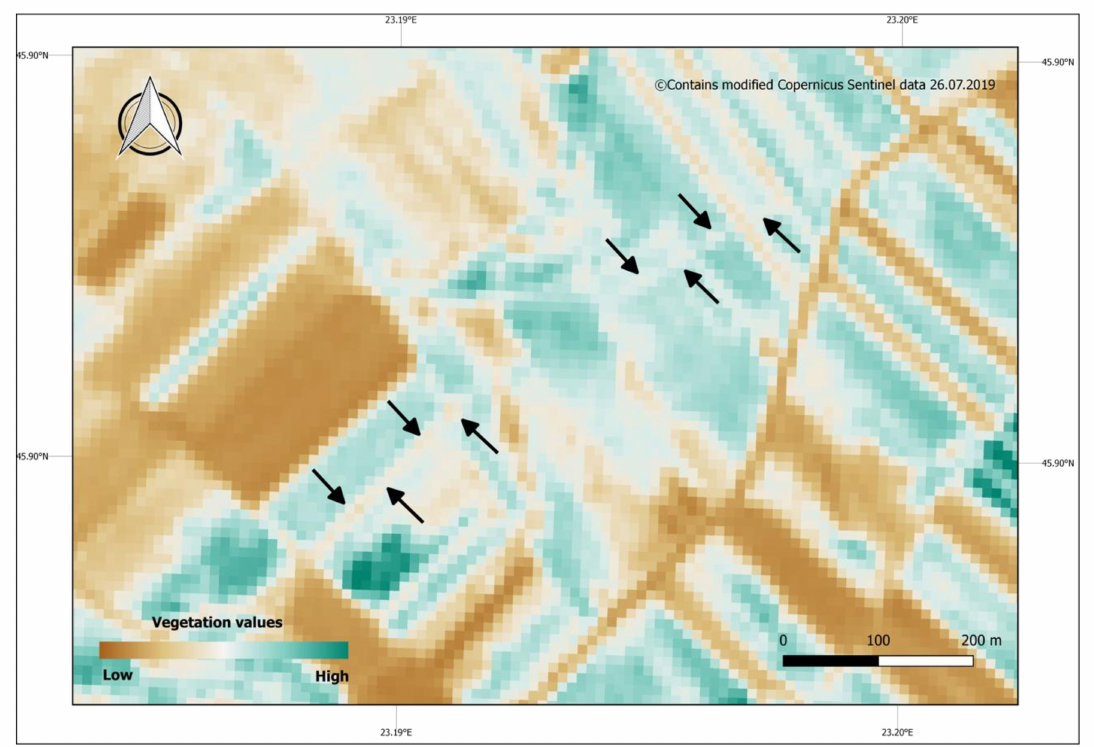
Figure 18. SR image output derived from Sentinel–2 imagery. The highlighted features represent traces of the underground Roman road that connected Germisara Roman Fort with Geoagiu–B ă